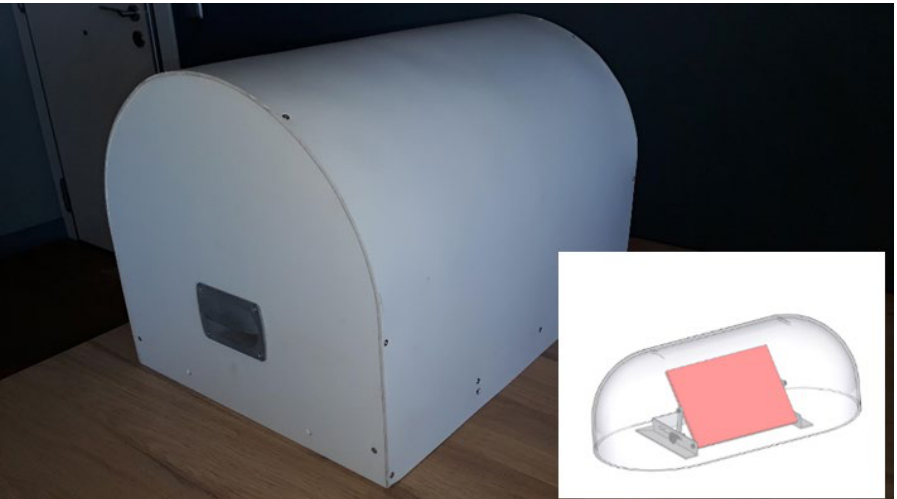
Figure 3. Picture of the external cover of the AR with a scheme of the mechanical